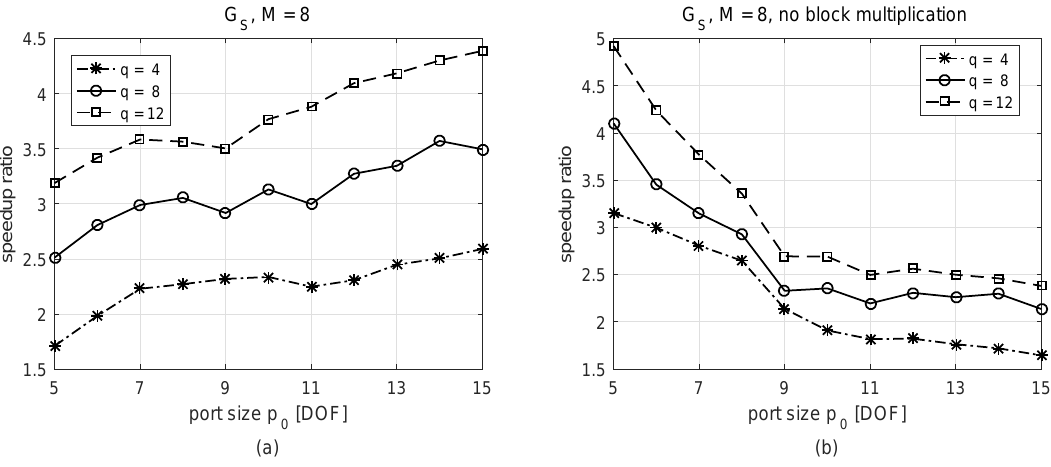
Figure 7. Gain of the Schur solver over the standard MATLAB solver for the system comprising diagonalized macromodels. The Schur solver is in two options: with ( a ) or without ( b ) the dedicated block matrix